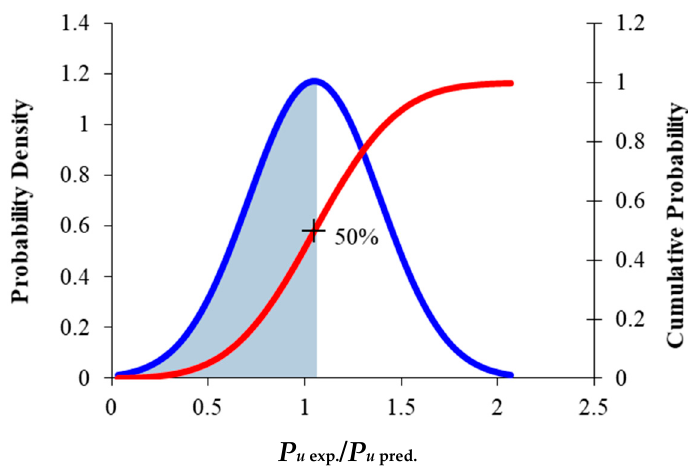
Figure 5. Distribution of the frequency of the experimental/predicted values of P u .